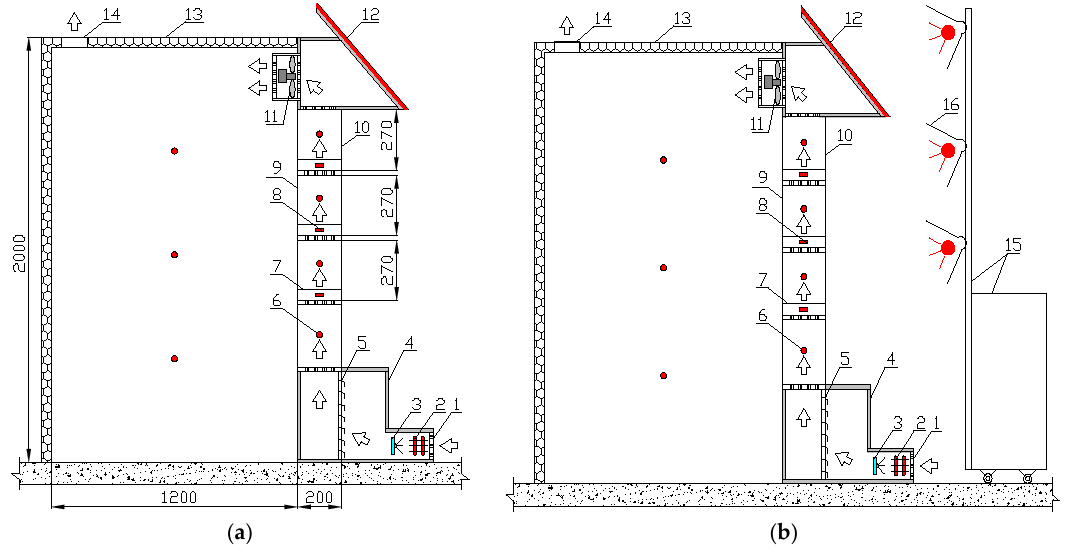
Figure 2. Testing rig of the proposed SPDW: ( a ) dehumidification mode; and ( b ) regeneration mode 1-Air inlet; 2-Electric heater; 3-Ultrasonic humidifier; 4-Mixing chamber; 5-Double shutter; 6-Temperature/humidity sensor; 7-Solid desiccant module (Silica gel); 8-Thermocouple; 9-Inner layer of the flat-plate glass; 10-Outer layer of the flat-plate glass; 11-Fans; 12-PV panel; 13-Testing space; 14-Air outlet; 15-Bracket; 16-Xenon lamps.